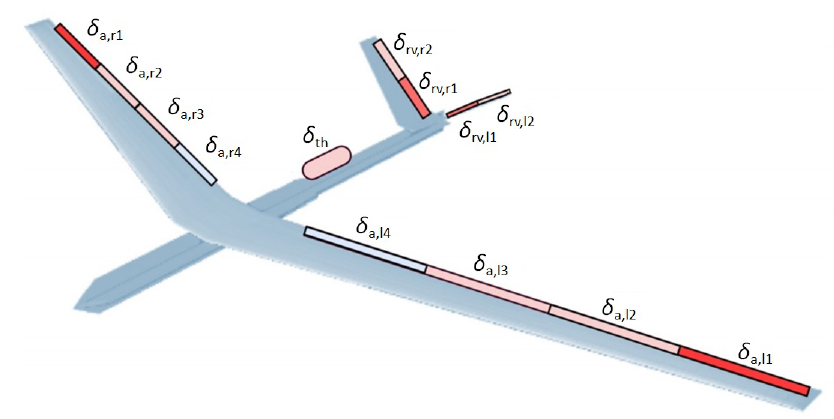
Figure 3. Control surface